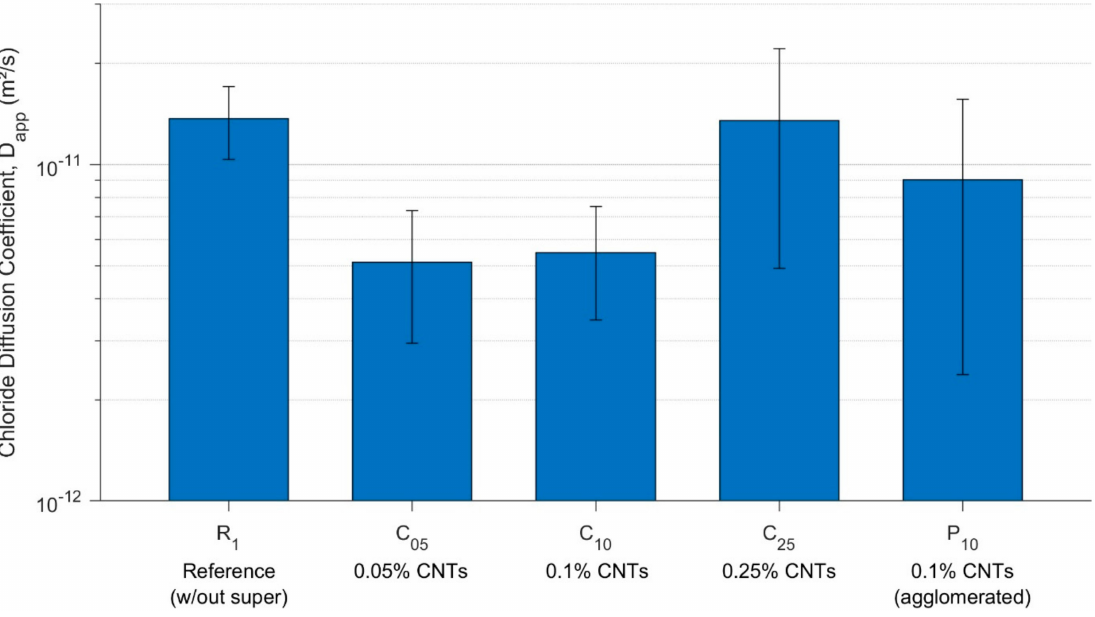
Figure 11. Comparison of the calculated coe ffi cients of chloride di ff usivity for specimens. Error bars show ± 1 s.d. of results across specimens (including estimated experimental